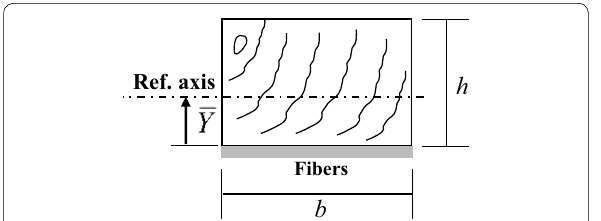
Fig. 5 The rehabilitated cross‑section applied for calculating MOE